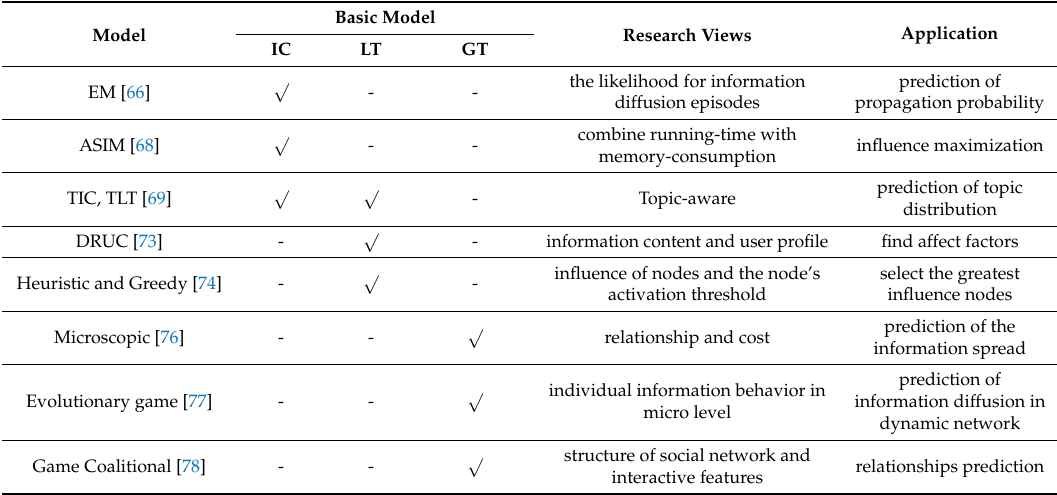
Table 5. Comparison of Independent Cascade Model (ICM), Linear Threshold Model (LTM) and Game Theory Model